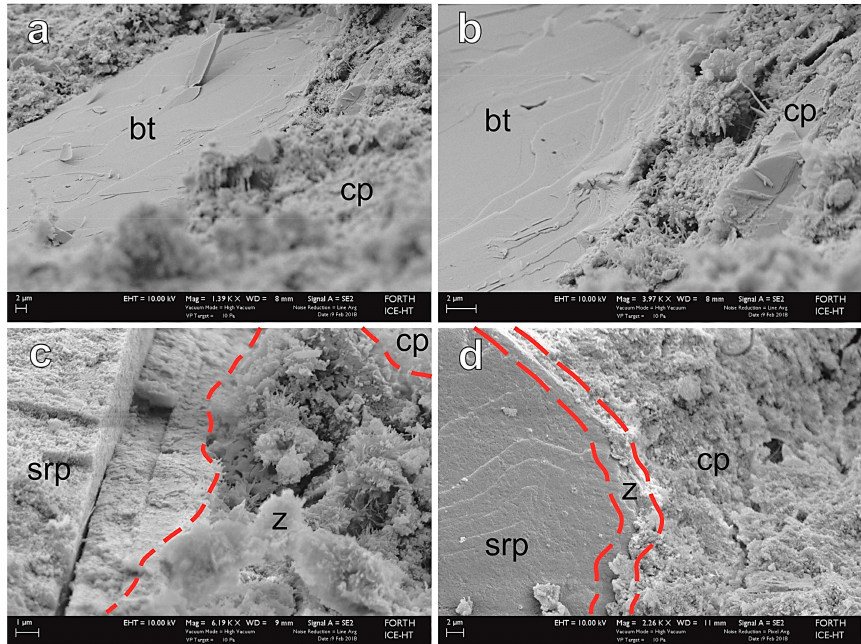
Figure 8. Back-scattered electron images of concrete specimens: ( a ), ( b ) large phenocrysts of biotite create surfaces of weakness in a concrete specimen made with andesite aggregates (sample BE.82); ( c ) formation of a reaction zone and abrupt platy separation between a serpentinite particle and the cement paste in concrete specimen BE.133); ( d ) reaction zone between a serpentinite particle and the cement paste in concrete specimen BE.103. Abbreviations: bt: biotite, cp: cement paste, srp: serpentinite aggregate, z: reaction zone. Red lines constrain reaction zones formed between aggregate particles and cement